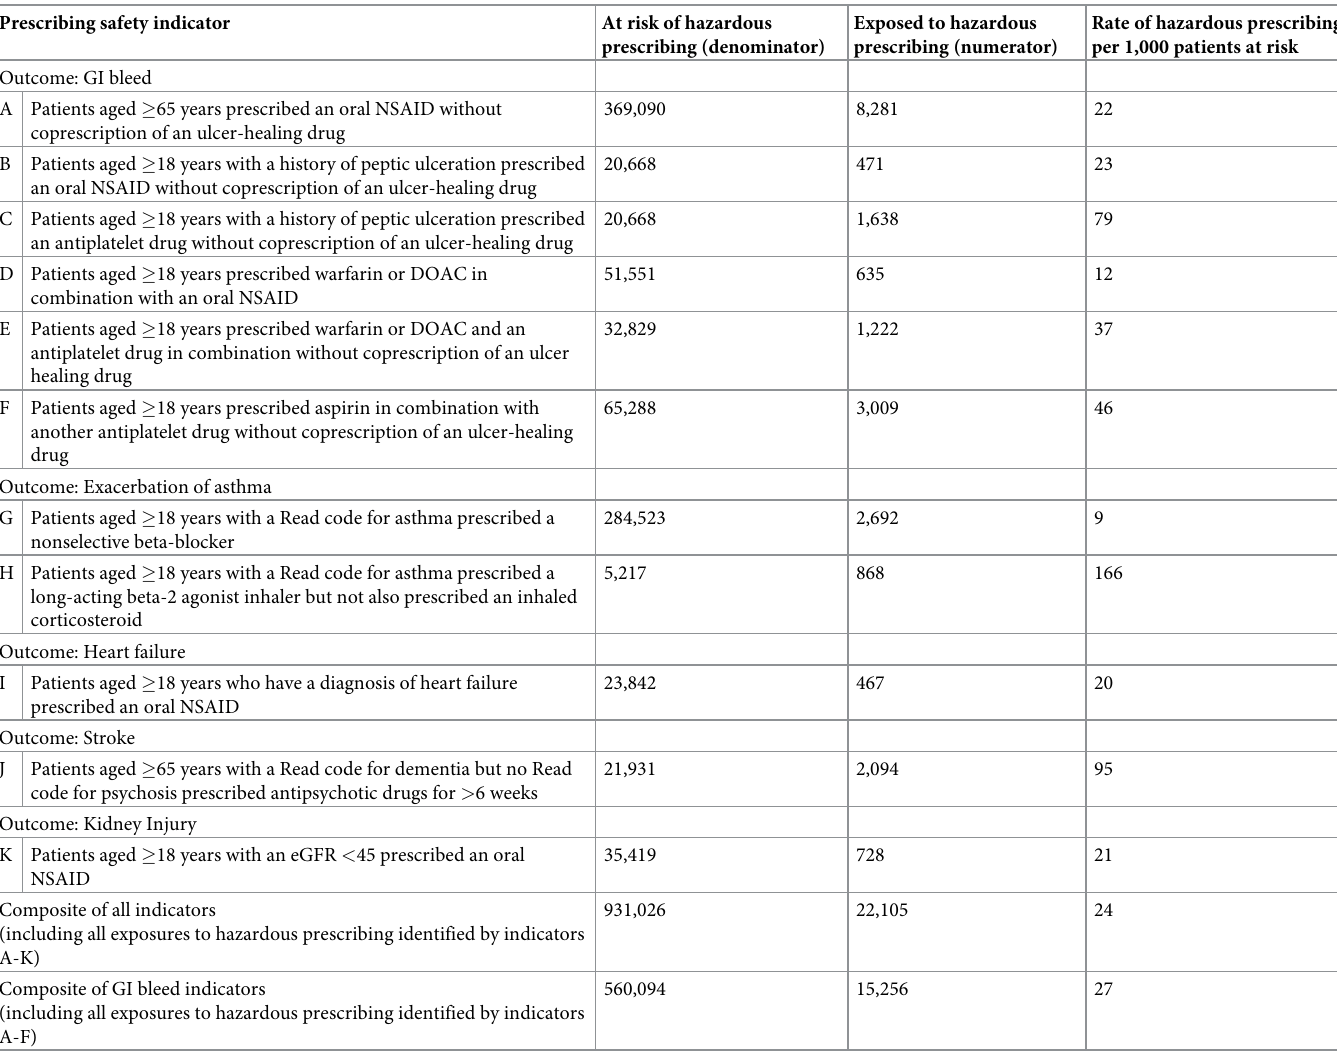
Table 3. Number of “at-risk” patients identified at baseline ( n = 370